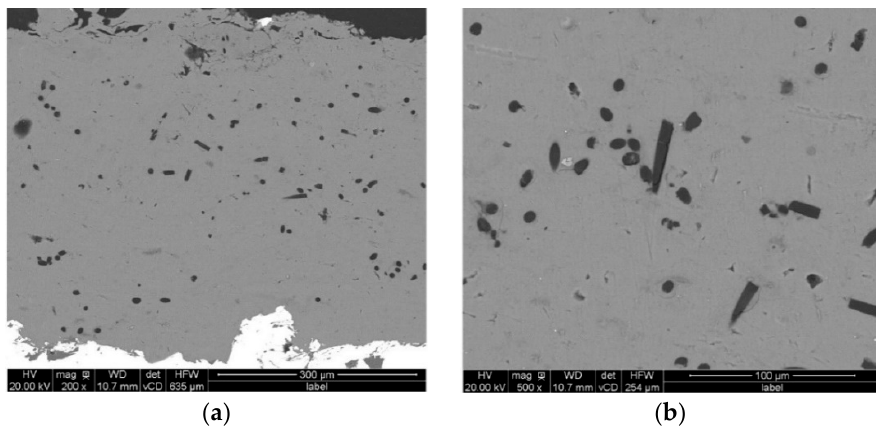
Figure 3. Cross-sectional SEM views of the as-deposited Al-CF coatings deposited on the substrate; ( a ) 200× magnification and ( b ) 500× magnification.